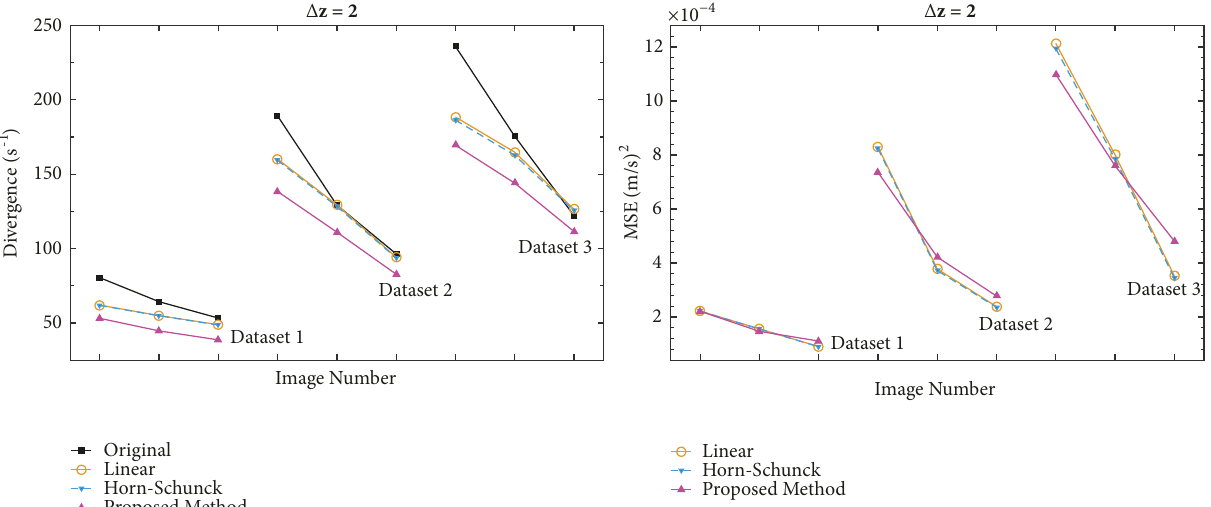
Figure 5: Divergence and MSE comparisons when slice distance is 2mm.